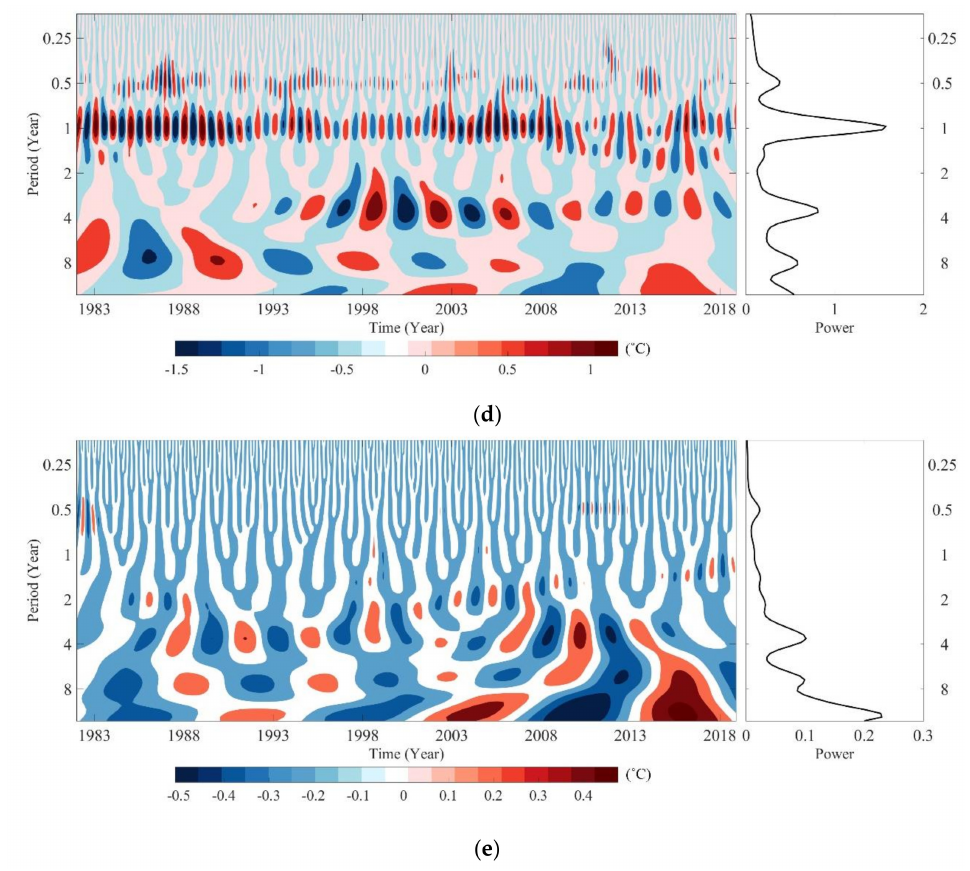
Figure 9. Wavelet transform spectrum and corresponding mean power of ( a ) Size variation; ( b ) Zonal center movement; ( c ) Meridional center movement; ( d ) Maximum SST; ( e ) Mean SST of the